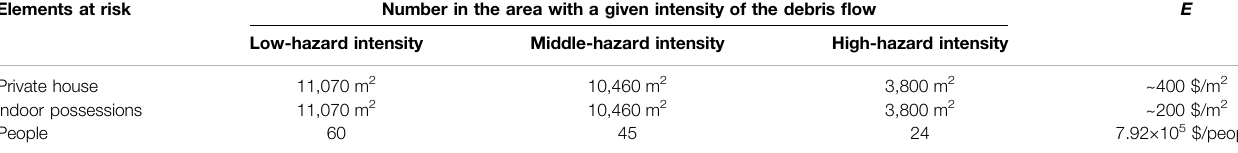
TABLE 2 | Values of E for the elements at